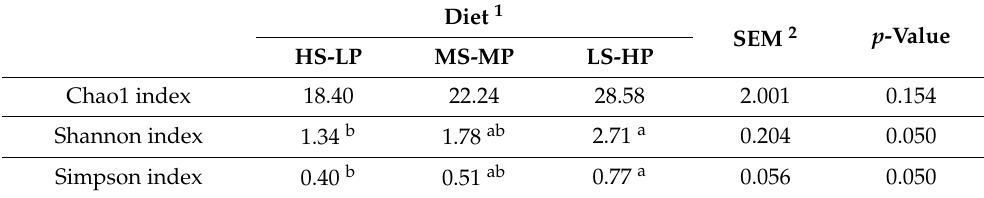
Table 7. Effects of the diets on Alpha diversity microbiota of Tenebrio molitor larvae.